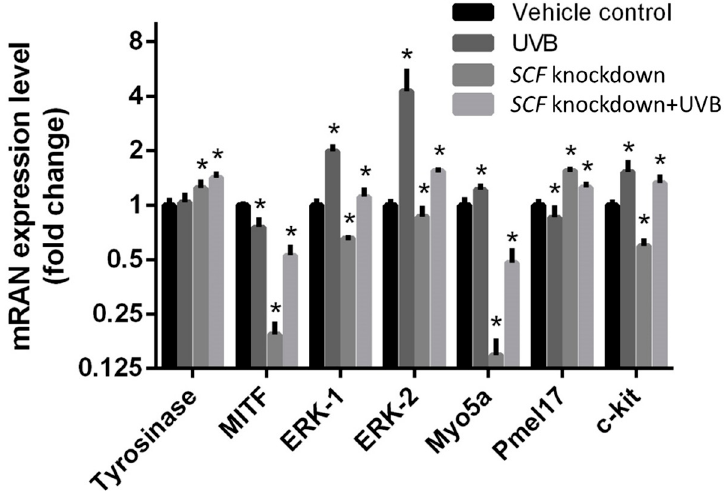
Figure 3. The effects of different conditioned media on the mRNA expression levels were compared with regular fibroblasts, fibroblasts simulated UVB, fibroblasts with SCF knockdown, and fibroblasts exposed UVB with SCF gene silenced. The data are presented as means ± SD; n = 3, * p < 0.05.